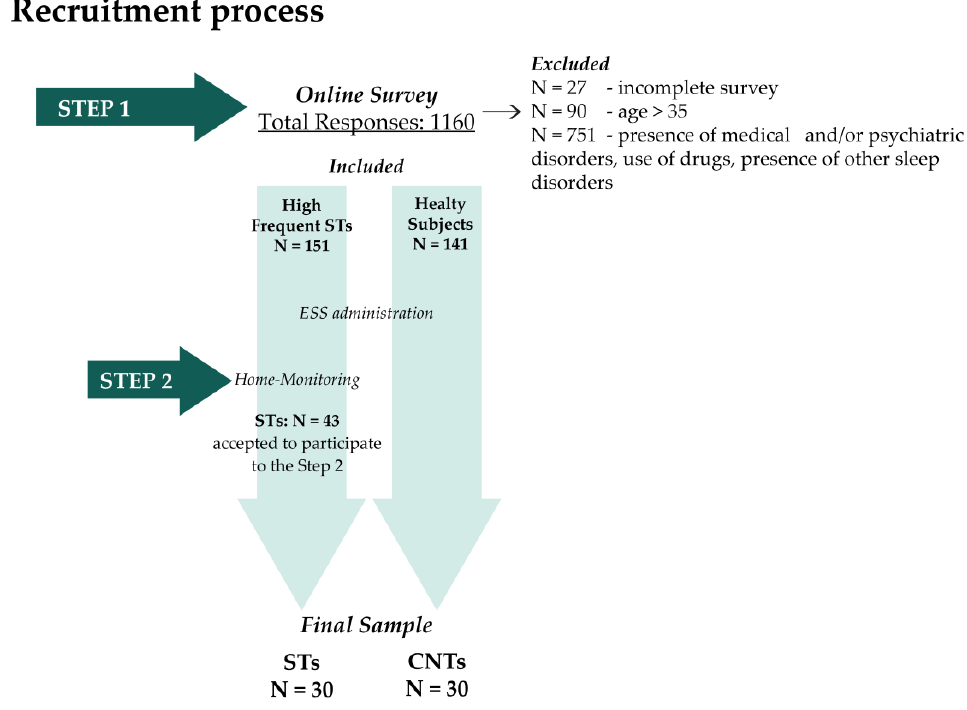
Figure 1. Recruitment process. Abbreviations: STs, Sleep Talkers’ group; CNTs, healthy; ESS, Epworth Sleepiness Scale.